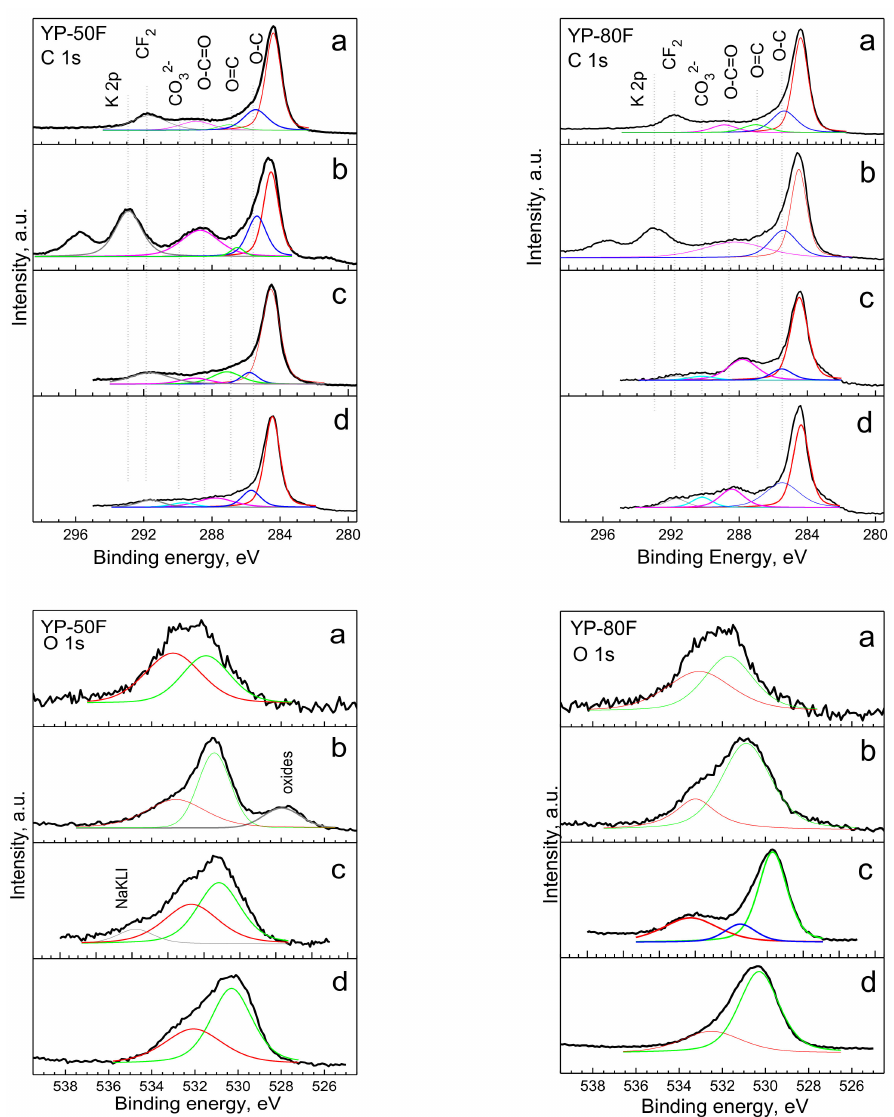
Figure 5. C1s and O1s spectra for YP-50F and YP-80F: pristine YP-50F and YP-80F electrodes ( a ) and cycled YP-50F and YP-80F electrodes in 6M KOH ( b ), 6 M NaOH ( c ) and 6 M LiOH ( d )